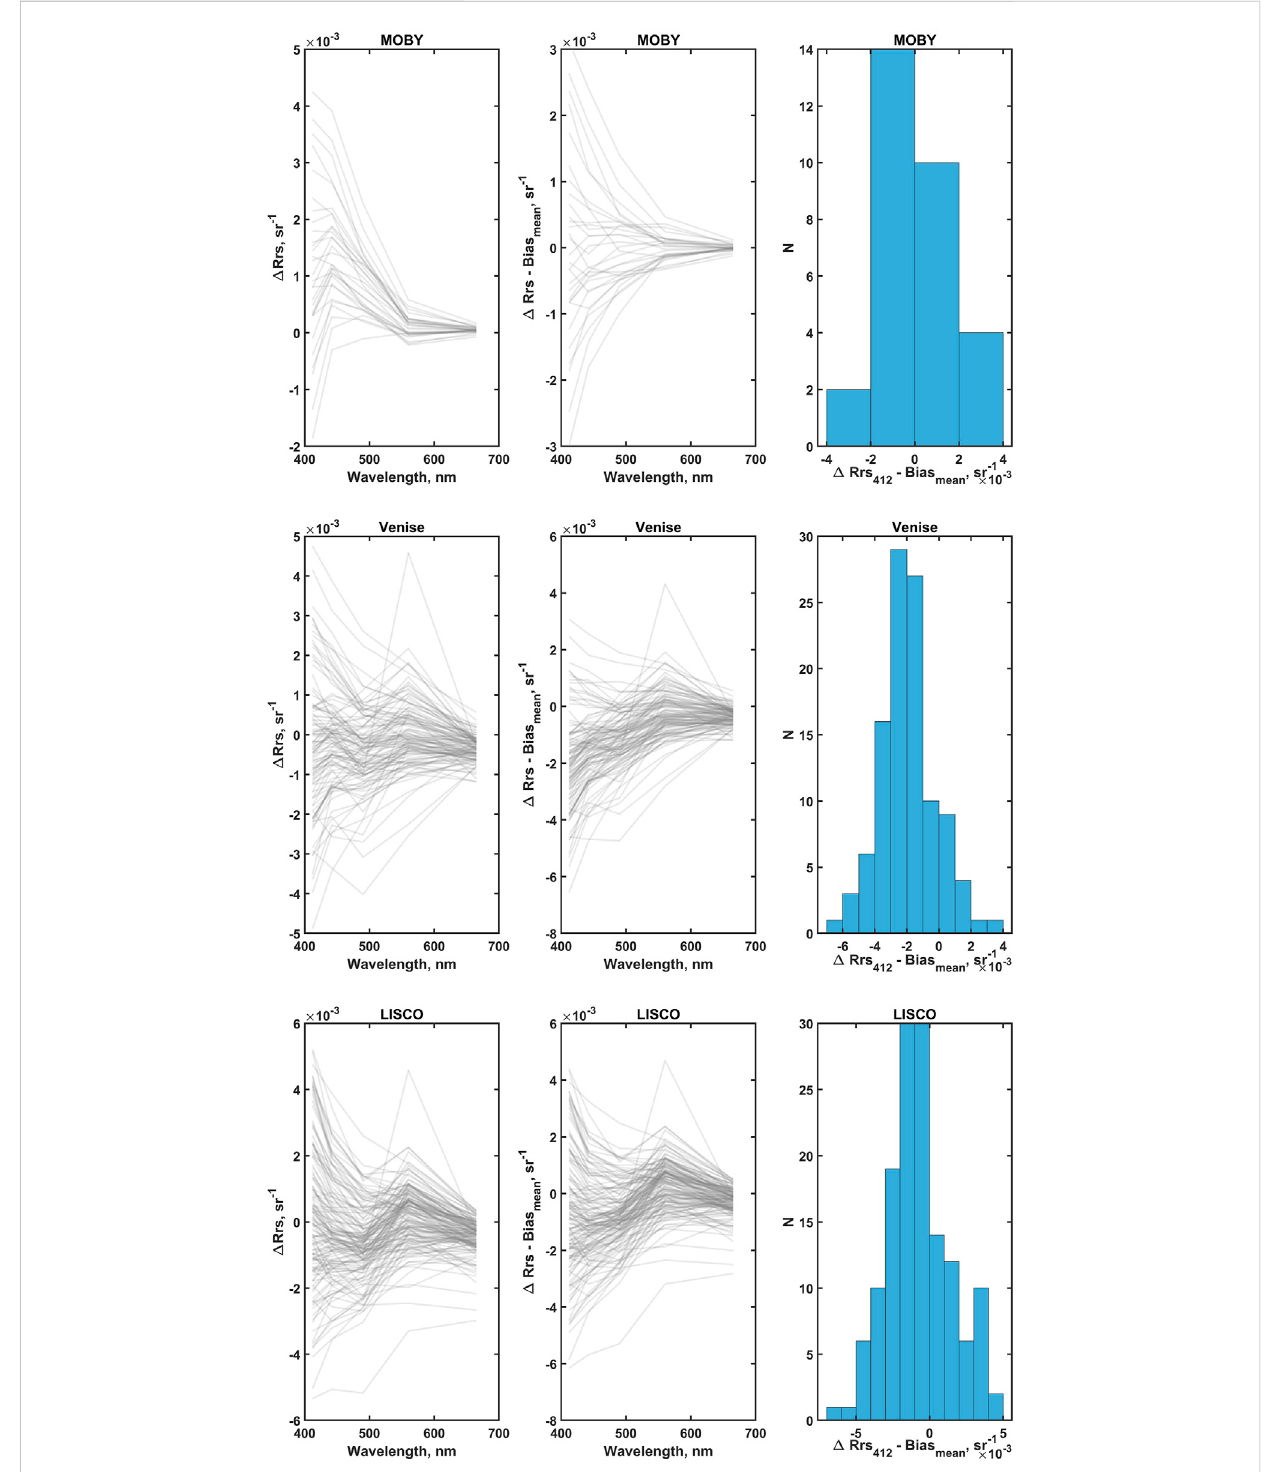
FIGURE 9 AnalysisoftheS3A Δ R rs distributionforMOBY,VeniseandLISCOsites.Firstcolumn:all Δ R rs ,secondcolumn:all Δ R rs — meanbiasforthestation,third column: histogram of all Δ R rs – mean bias for the station at 412